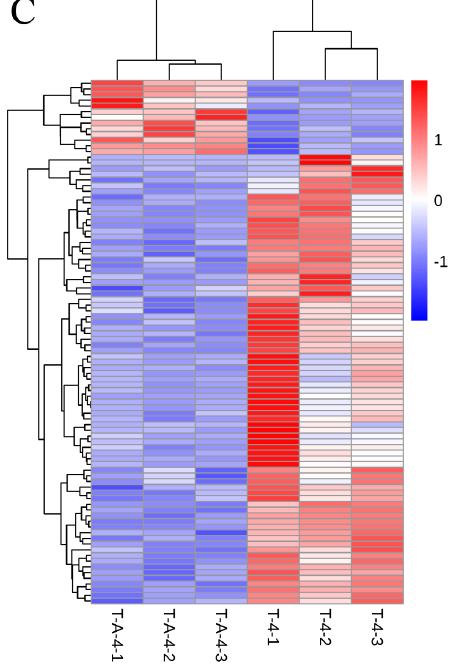
Forests 2023 , 14 , x FOR PEER REVIEW 19 of 22